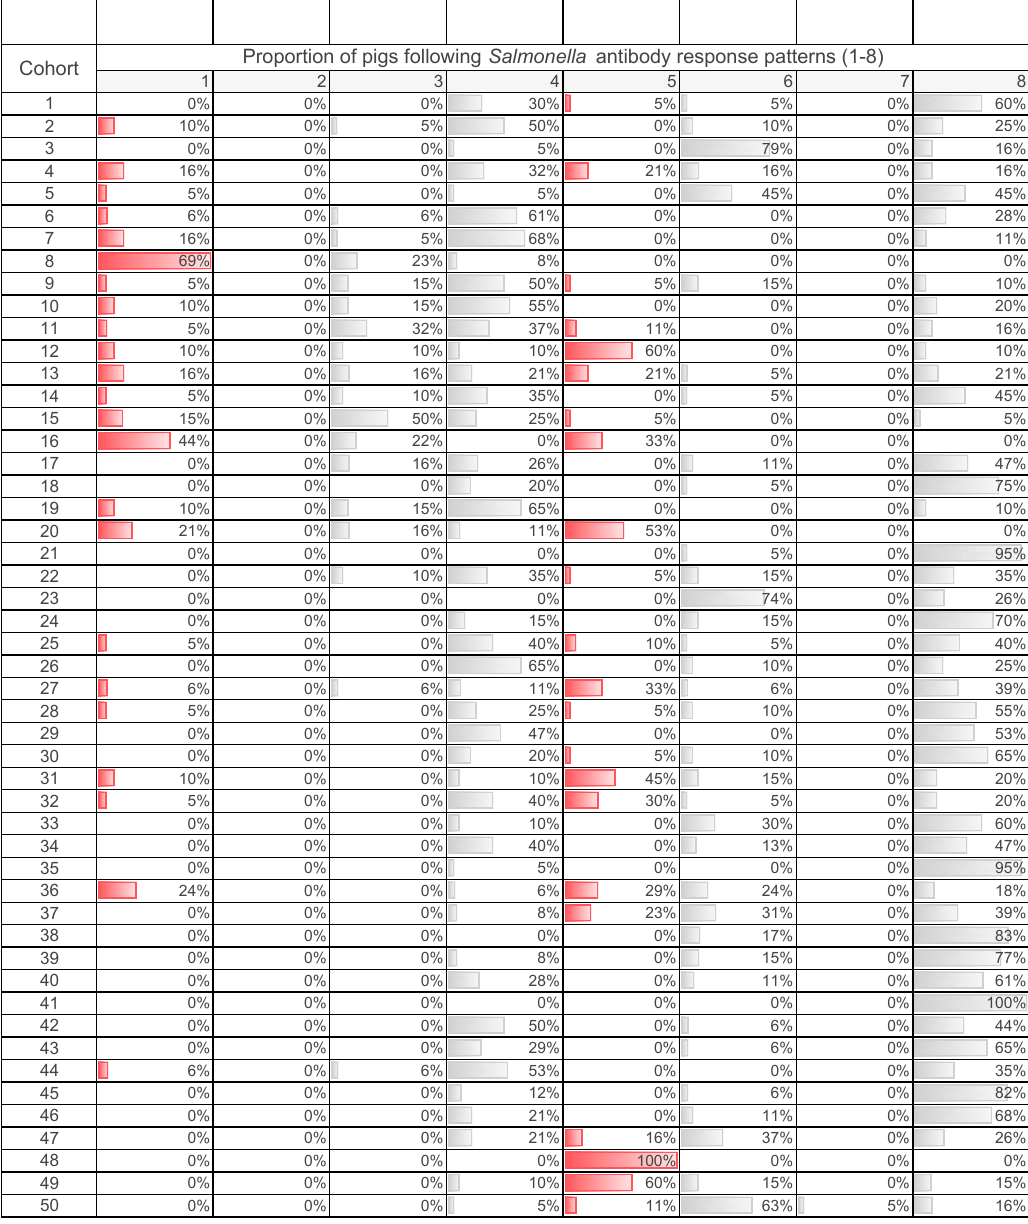
Table 4. The change in Salmonella antibody titres in nursery pigs ( n = 930) from visit 1 (V1; weaning) to visit 2 (V2; end of nursery) was characterized into eight Salmonella antibody response patterns (1 to 8) a and aggregated to the cohort level ( n = 50) b . This table captures the proportion of pigs following patterns 1 to 8 within each